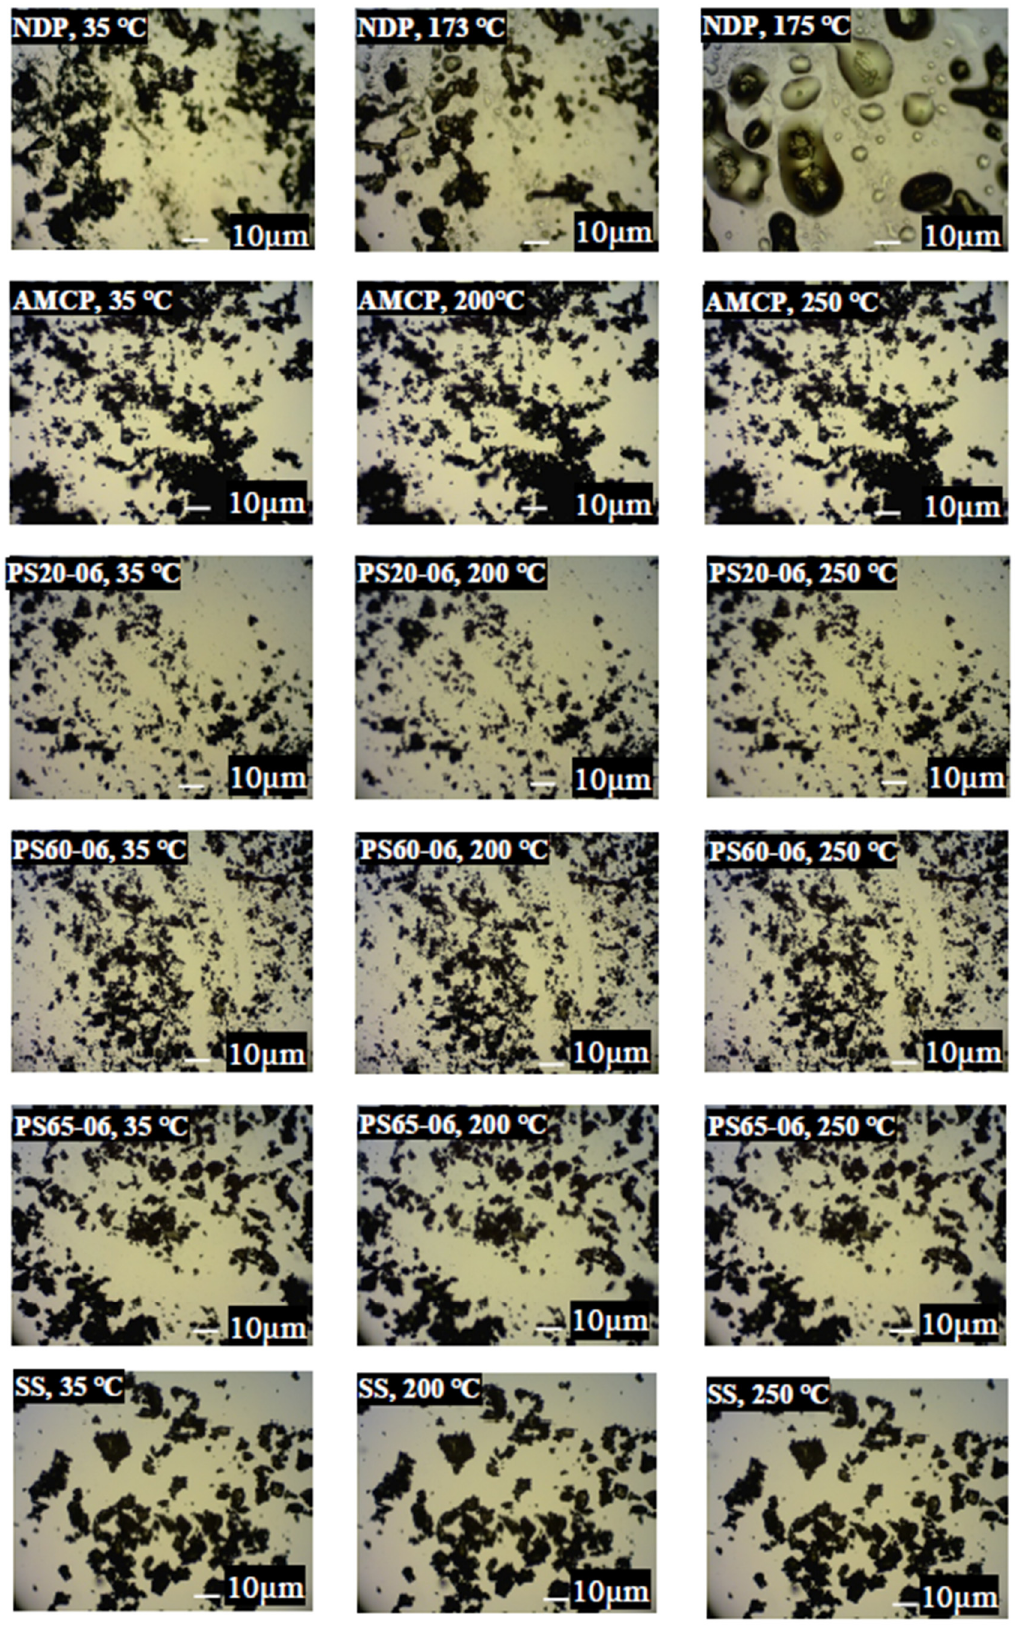
Figure 2. Hot stage microscopy images (magnification, × 400) of nifedipine, amino methacrylate copolymer, and the solid solutions collected at different temperatures.